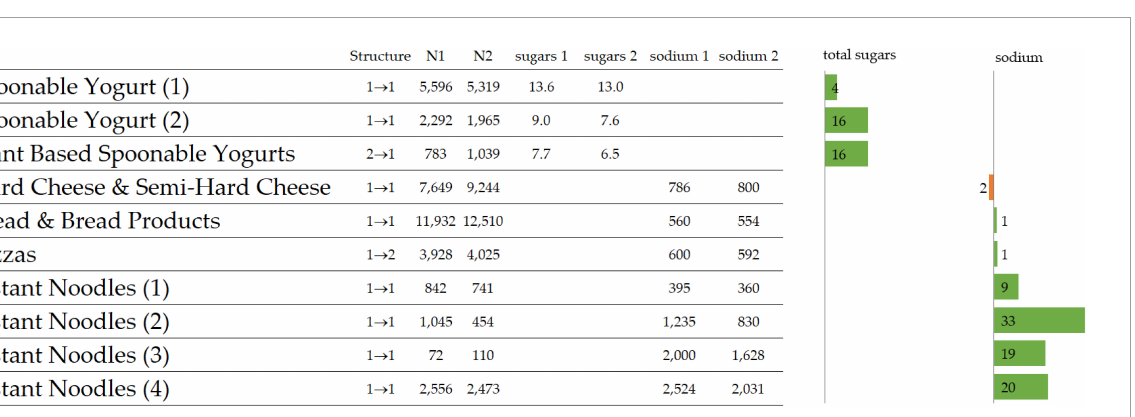
FIGURE2 Ten selected nutritionally homogeneous subcategories, type of structural changes between 2016 and 2020, Number of products N1 for 2016–2018 and N2 for 2018–2020, sugar content (g/100 g) and sodium content (mg/100 g) and relative improvement between the two periods as bar charts.